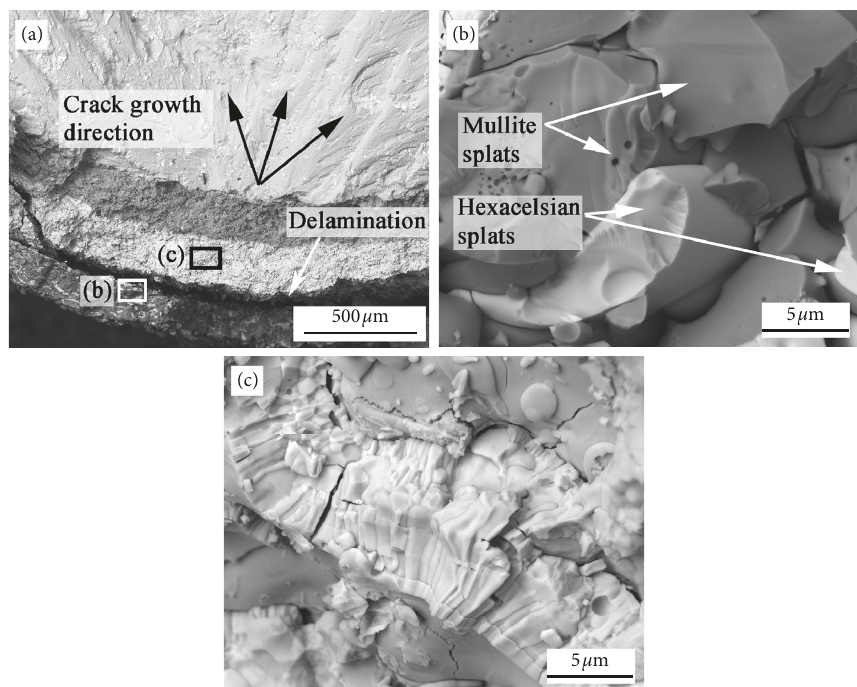
Figure 5: Fracture surface of the specimen fatigued to failure, ε fracture of the upper layer splats; (c) cleavage fracture of the YSZ splats.